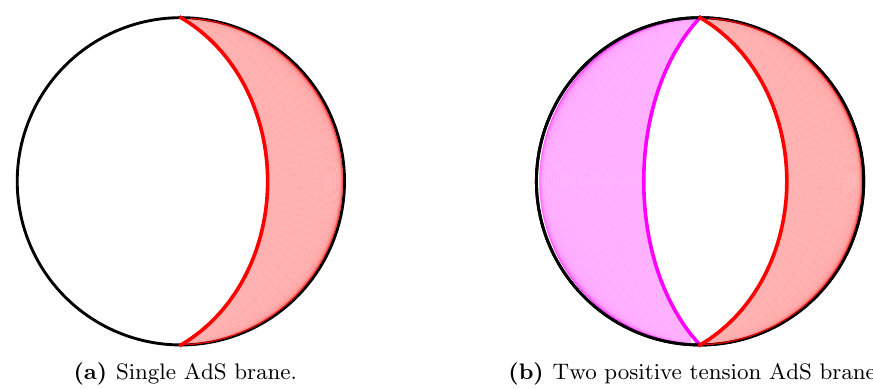
Figure 4. Horizontal cross sctions of Anti-de Sitter